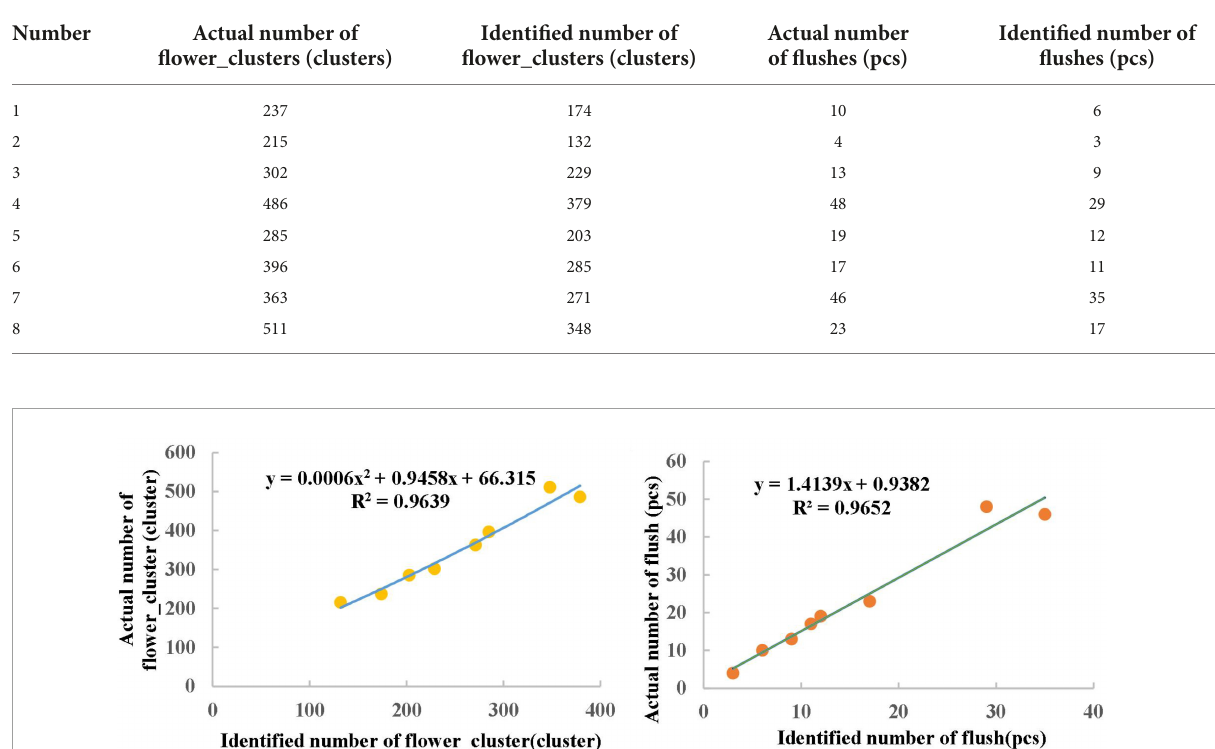
TABLE 5 Quantitative information for the manual counts and the YOLOv4 model detection results.